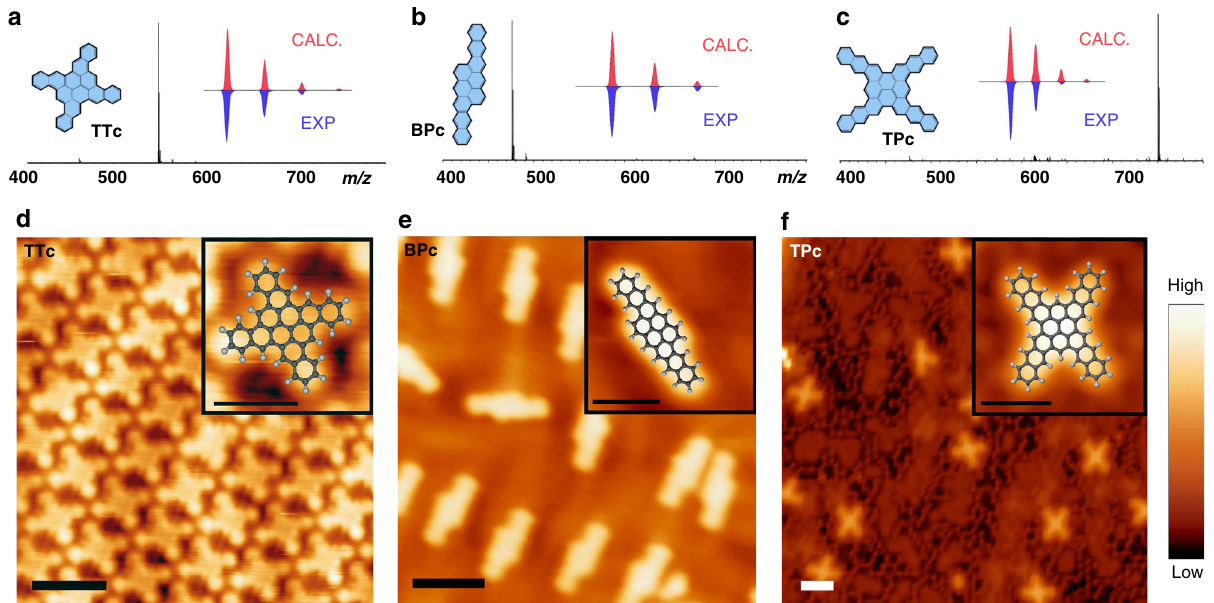
Fig. 5 Structure elucidation of larger NGs – TTc , BPc and TPc . a – c LDI-MS, insets show the calculated and measured isotope pattern, respectively; d – f STM images of TTc on Au(111) at 77 K, BPc on Au(111) at 4.7 K and TPc on Ag(111) at 4.7 K. The perfect fi t of the superimposed DFT models corroborates the unambiguous identi fi cation of the NGs. The TPc ’ s are surrounded by bright protrusions that are assigned to halogens, which are residues from the synthesis (see SI). Scale bars: 2 nm and 1 nm for the insets with the DFT model overlaid images, respectively. Tunneling conditions: 100 pA/1 V, 50 pA/-